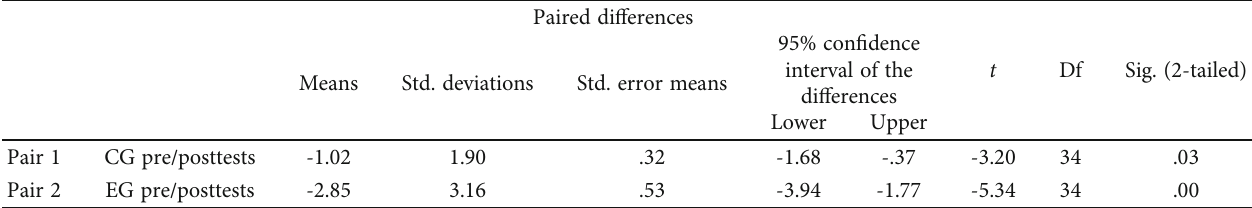
Table 5: Inferential statistics (paired samples test) of both groups on the pretest and posttest.